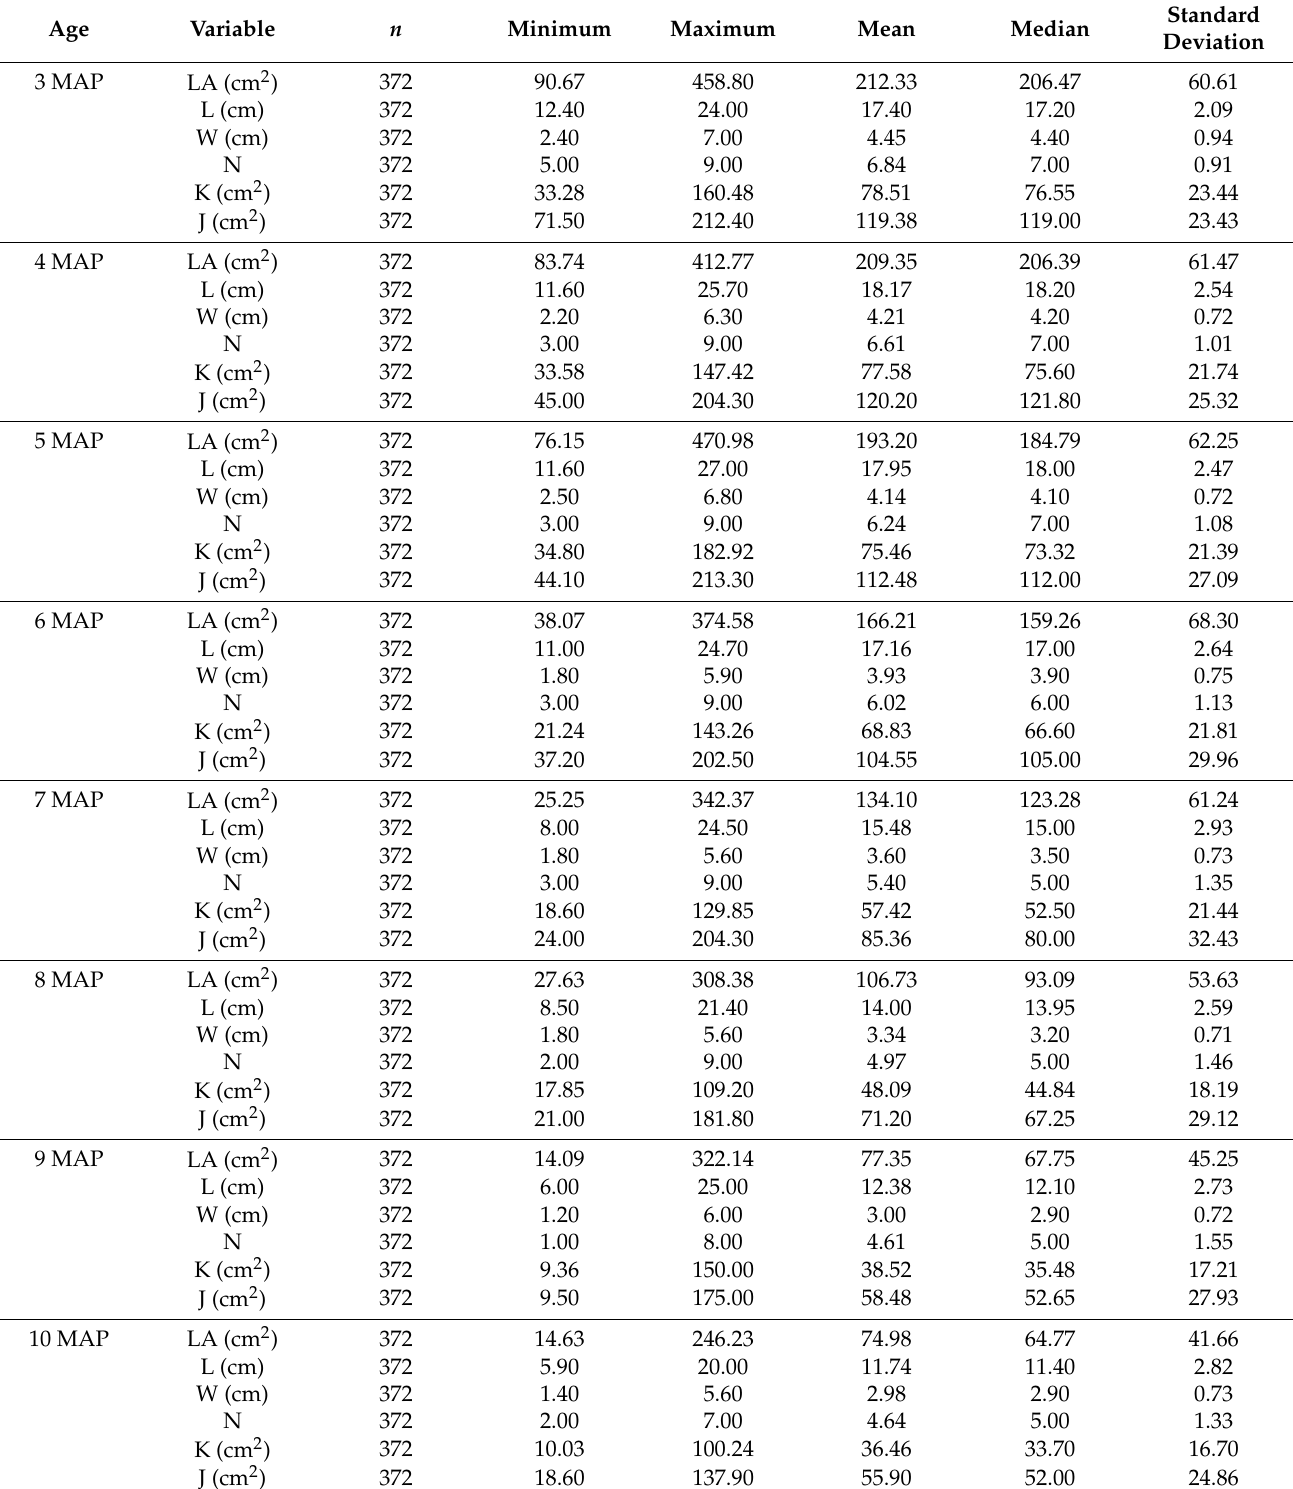
Table 1. Minimum, maximum, mean, median, and standard deviation of leaf area (LA), the length of the central lobe (L), the width of the central lobe (W), the number of lobes (N), the product of the length and width (K), and the product of the length and number of lobes